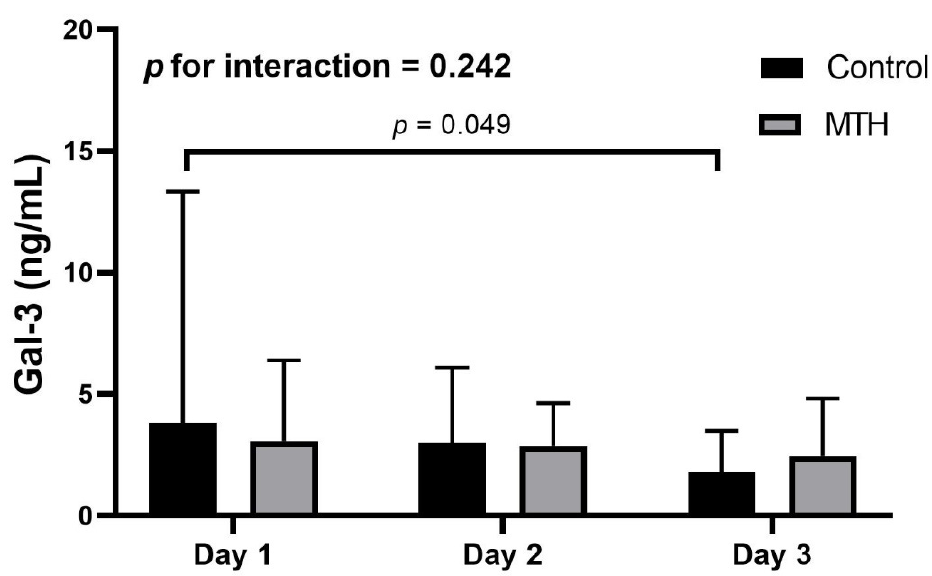
Figure 2. Galectin-3 levels of patients in cardiogenic shock after acute myocardial infarction treated by either MTH or control groups during three days after admission. Box and whisker plots show median and interquartile range. MTH, mild therapeutic hypothermia.